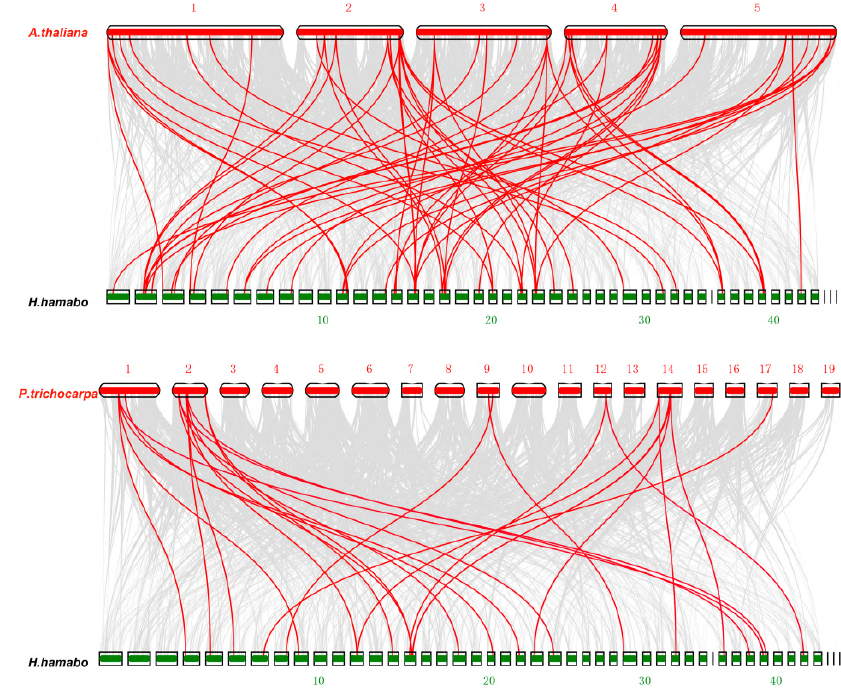
Figure 5. Synteny analysis maps of H. hamabo with Arabidopsis and Populus . Gray lines in the background indicate the collinear blocks within H. hamabo and other plant genomes, while the red lines highlight the syntenic bHLH gene pairs.